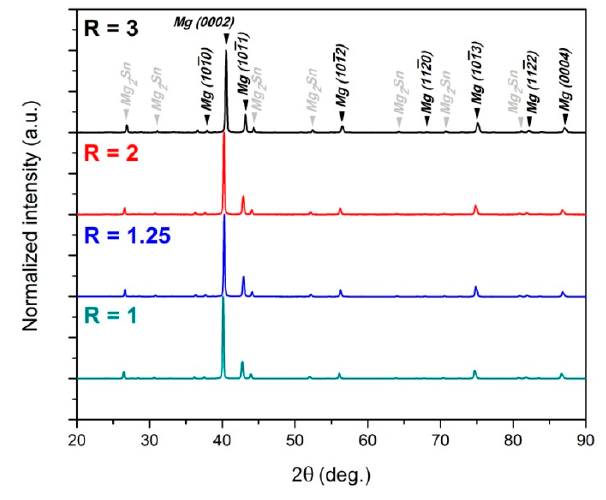
Figure 4. XRD patterns of as-rolled Mg-6Sn sheets processed at speed ratio of R = 1, 1.25, 2 and 3.